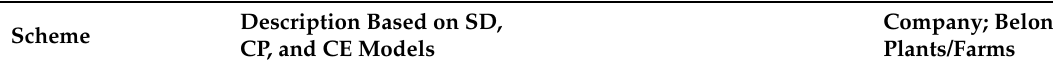
Table 3. Strategic activities realized in ´Smiłowo